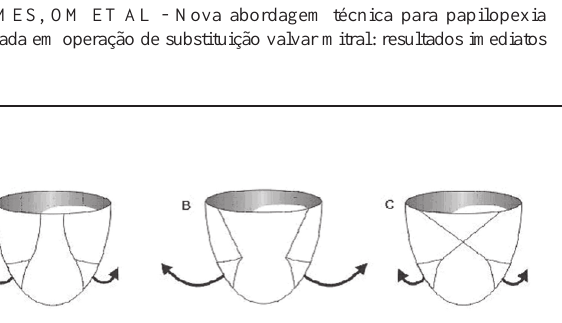
Fig. 4 - Diagrama de correlação entre os tipos de papilopexia e potencial para dilatação diastólica ventricular (A-Normal, B-Paralela, C-Cruzada)